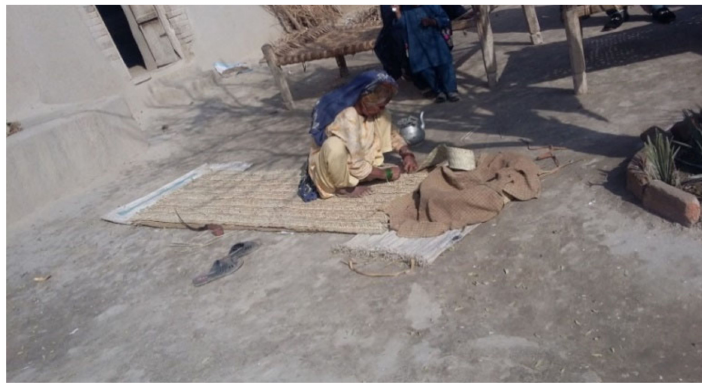
Figure 4. An old woman making mat with date leaves in union council S.